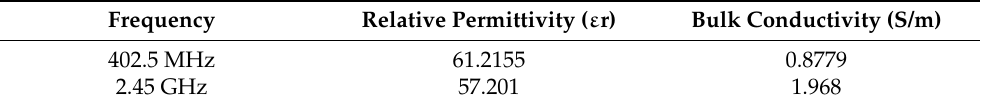
Table 1. Dielectric properties of the pancreas [18].